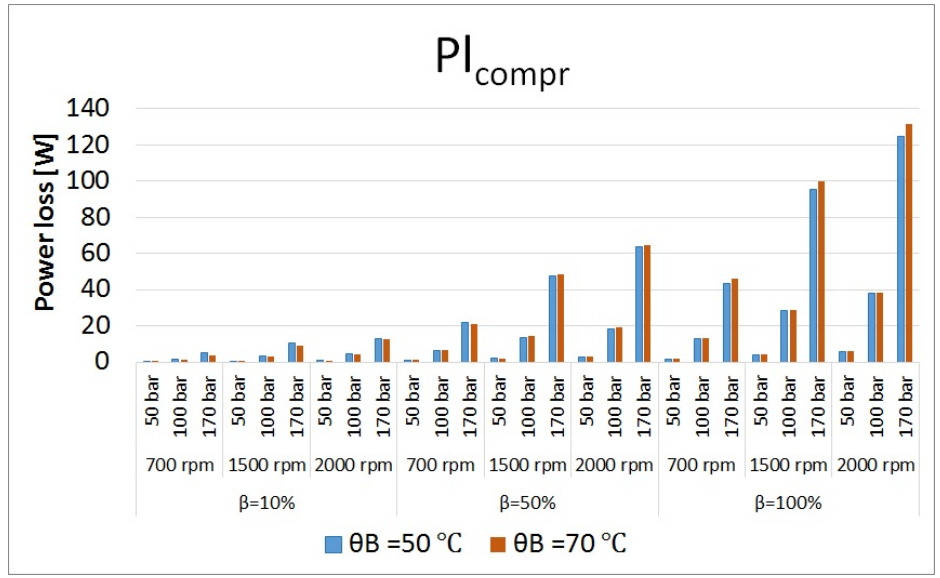
Figure 23. Compression power losses at different operating conditions.